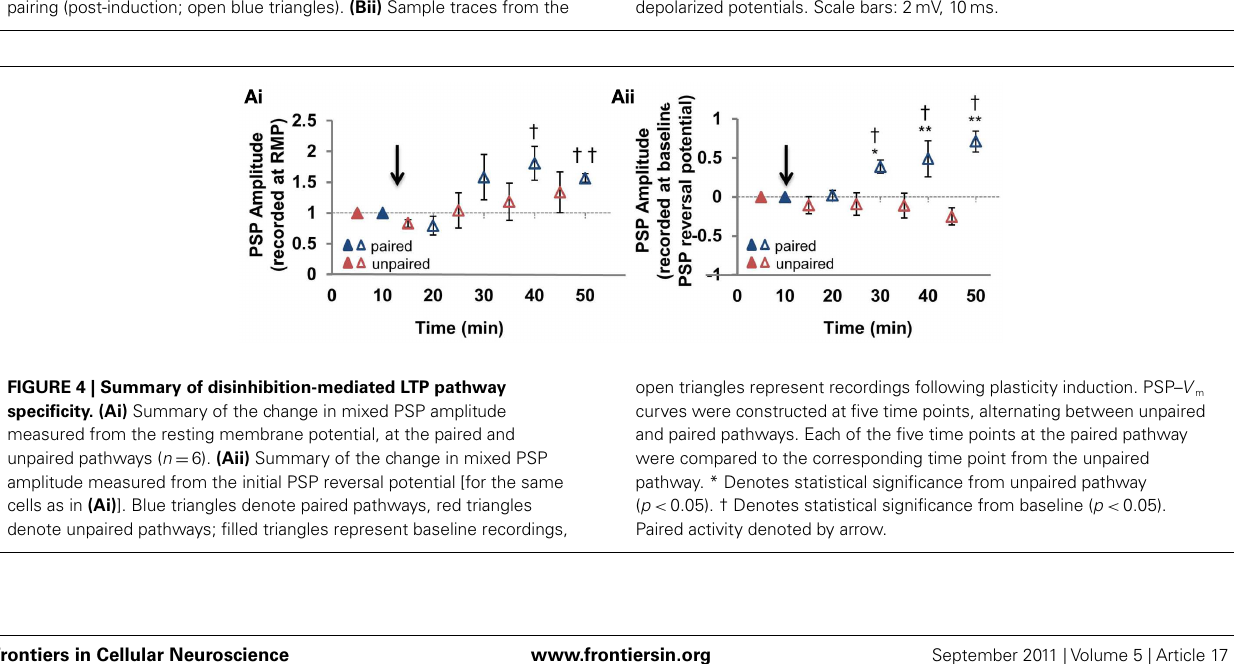
experiment plotted in (Bi) . Current waveforms are overlaid from the baseline period (black) and from the last post-induction time point (gray), for relatively hyperpolarized and depolarized potentials. Scale bars: 2mV, 10ms. (Ci) PSP amplitude is plotted against V m for the unpaired pathway before (baseline; solid red triangles) and after pairing (post-induction; open red triangles). (Cii) Sample traces from the experiment plotted in (Ci) . Current waveforms are overlaid from the baseline period (black) and from the last post-induction time point (gray), for relatively hyperpolarized and depolarized potentials. Scale bars: 2mV, 10ms.